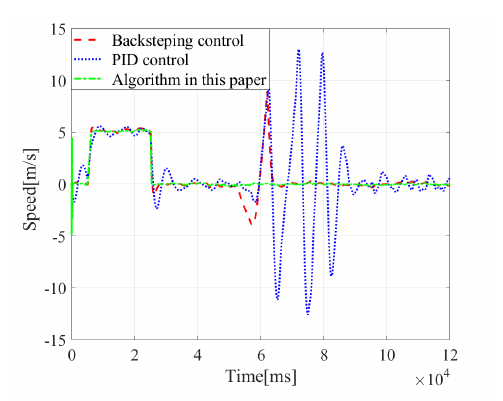
Fig. 4. Pitch angle curve in transition phase .